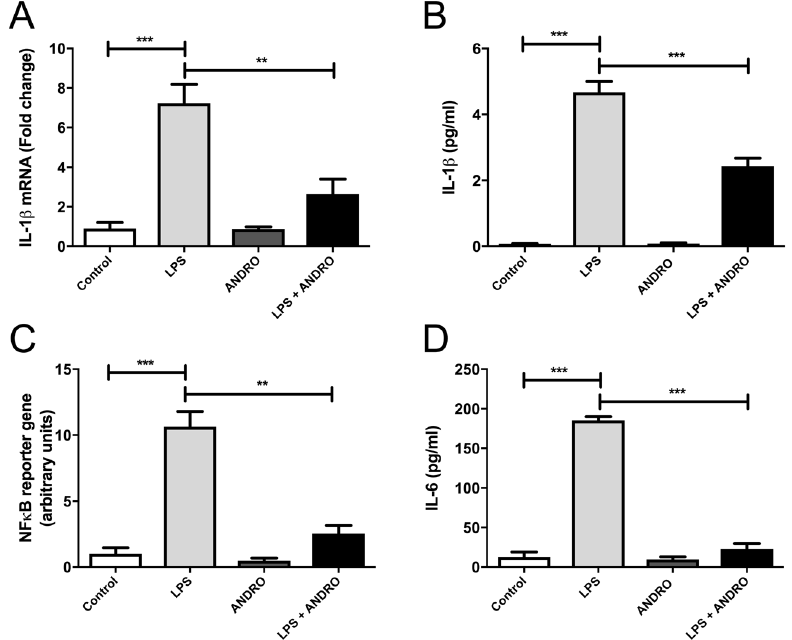
Figure 6. Andrographolide (ANDRO) inhibits IL-1 β expression through NF κ B inhibition. HepG2 cells were incubated for 24 h with palmitic acid to induce lipid droplet accumulation. Then, cells were stimulated with Lipopolysaccharides (LPS) (1000 ng/ml) for 24 h in the presence or absence of ANDRO (50 μ M). (A) interleukin-1 β (IL-1 β ) gene expression. (B) IL-1 β protein levels in the supernatant fraction were analyzed by ELISA. (C) Fat-laden HepG2 cells were co-transfected with NF κ B transcription factor-responsive firefly luciferase and Renilla luciferase constructs and treated with LPS (1000 ng/ml), ANDRO (50 μ M) or both. (D) IL-6 protein levels in the supernatant fraction. Statistical significance was evaluated using ANOVA with a post- hoc Bonferroni multiple-comparison test ( ** p ≤ 0.01 and *** p ≤ 0.001).